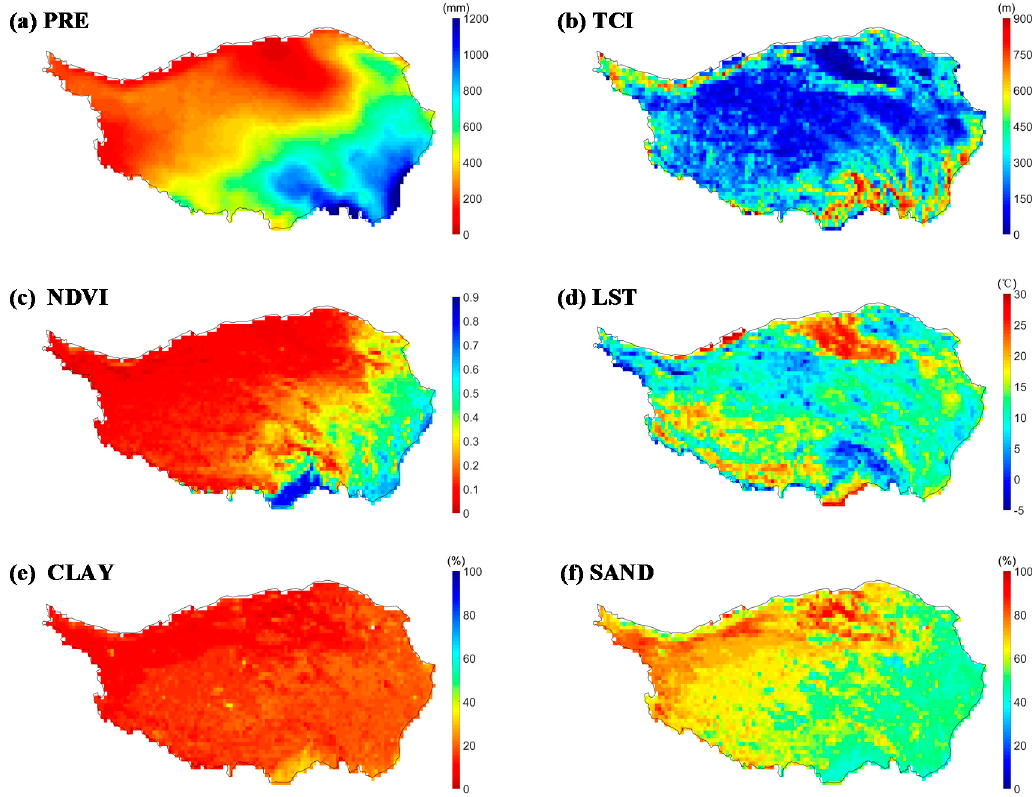
Figure 6. Spatial patterns of several climate and environmental variables over the QTP. The mean values of the land-surface temperature (LST) and normalized difference vegetation index (NDVI) (0.25°×0.25°) from April 2015 to July 2018 were used. PRE is the average annual precipitation from 2016 and 2017. The terrain complexity index (TCI), Clay, and Sand were relatively stable attributes for each period.